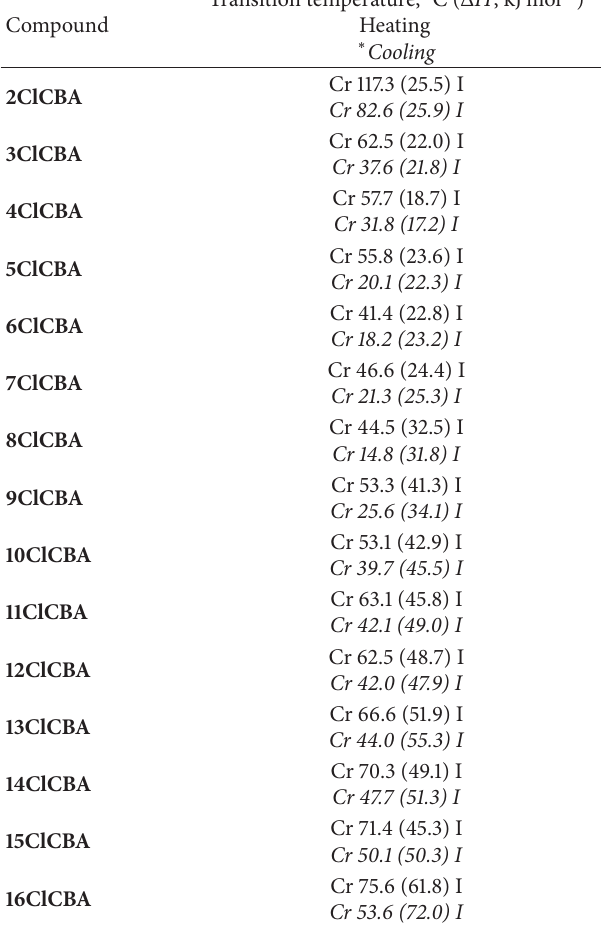
Table 2: Transition temperature and associated enthalpy changes of alkyl 4- { [(4-chlorophenyl)imino]methyl } benzoates upon heating and cooling